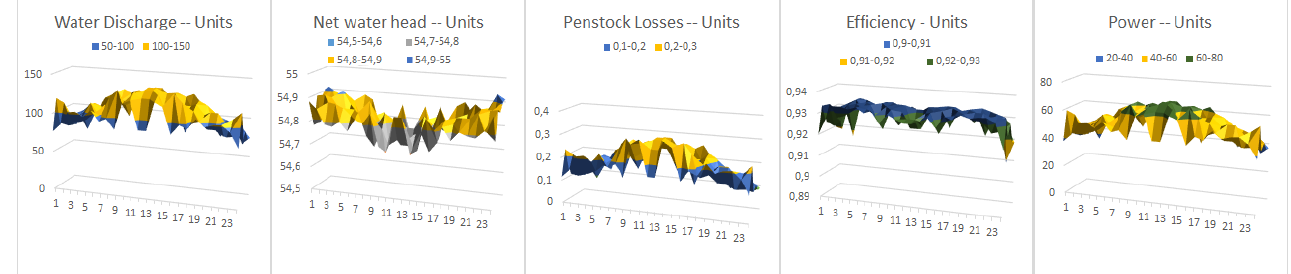
Figure 10. CRO with Harmony mutation— CRO ( 1 ) . Results of Water discharge (m 3 /s). Net water head (m). Penstock (m). Efficiency (%) and Power generated (MW/h). Daily dispatch (24 h).